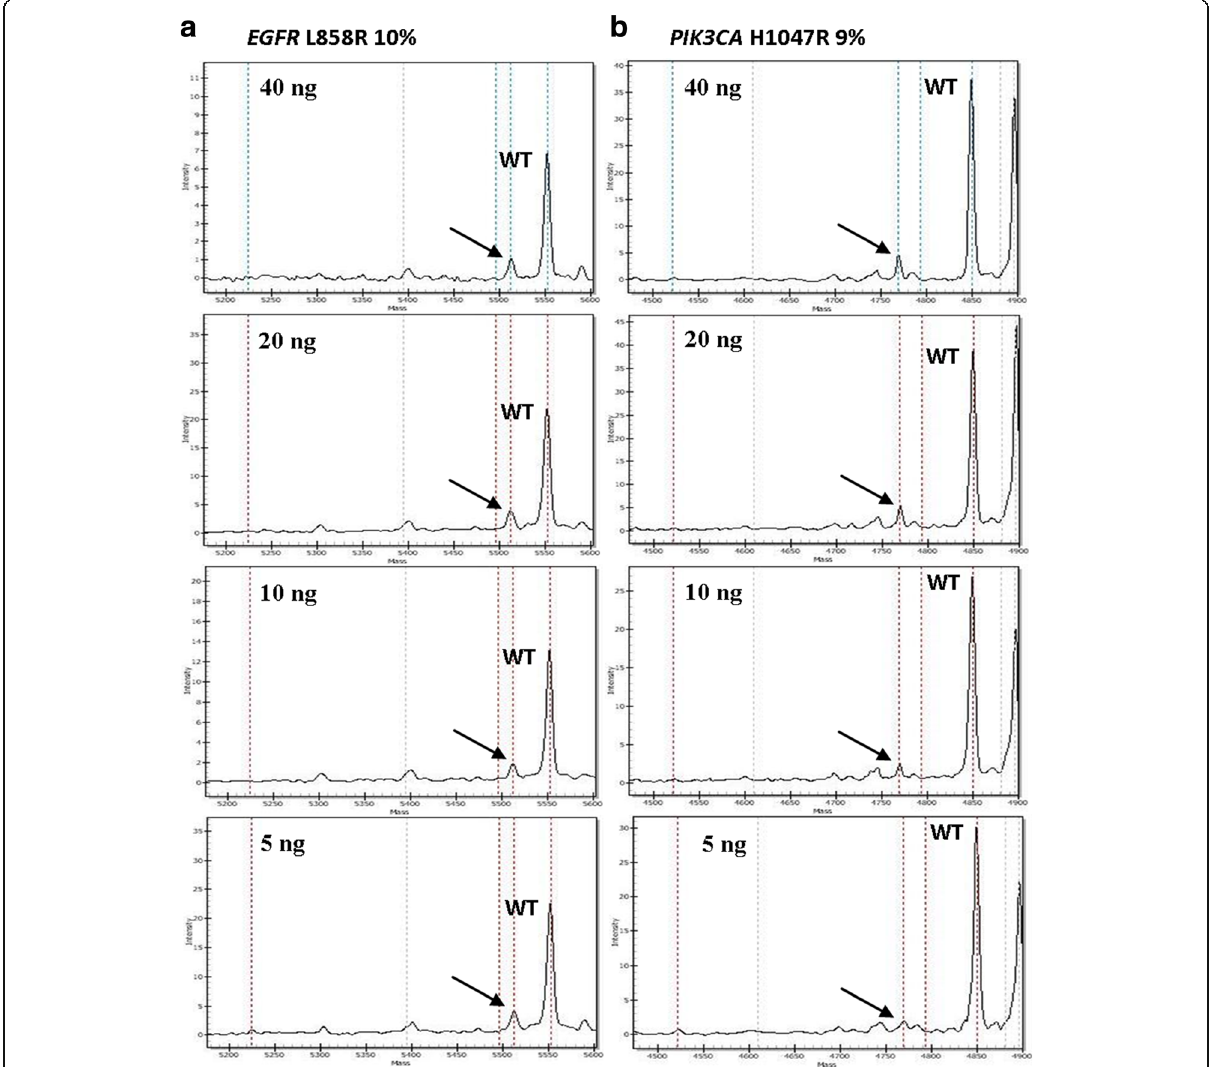
Fig. 2 Spectrograms, mass (x-axis) versus intensity (y-axis) from two histological samples ( a , b ) containing EGFR and PIK3CA mutations, respectively, at specific percentages of the mutated alleles (in brackets). Arrows indicate the mass peaks of the mutated alleles, using the specified decreasing amounts of DNA. The mass peaks of the wild-type alleles are also shown (WT). Using 5 ng of tumor DNA, the peak corre- sponding to the mutations was insufficient for a positive call for PIK3CA ( b ), but sufficient for